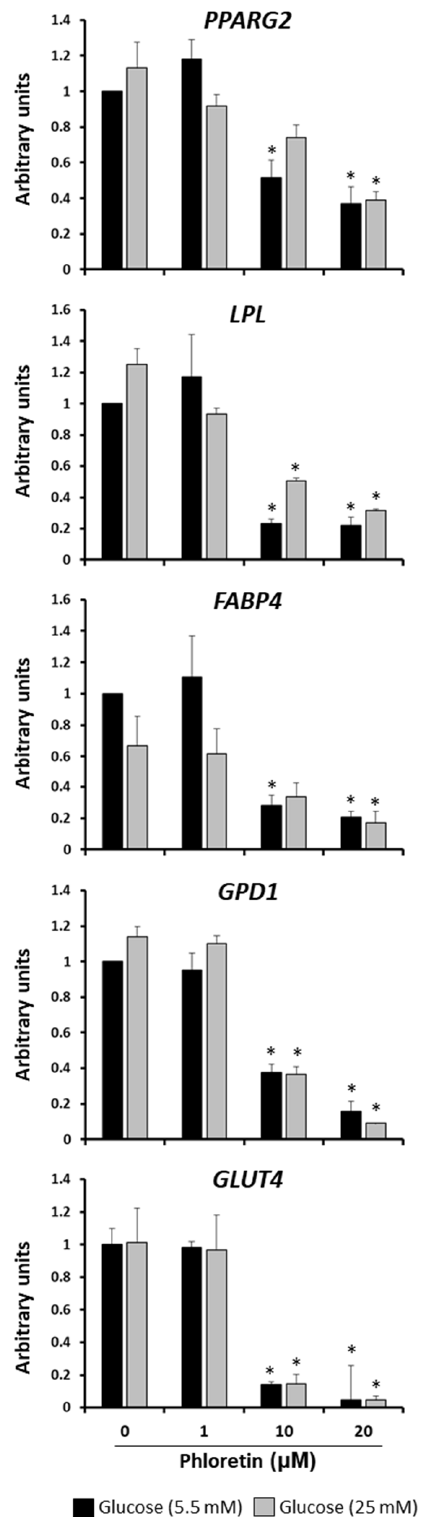
Figure 4. Gene expression of adipogenic marker genes, 13 days after beginning adipogenic differ- entiation of MSC cultures, in presence of 0, 1, 10, and 20 µM phloretin and 5.5 or 25 mM glucose. * p < 0.05 vs. cultures no treated (0 µM of phloretin).